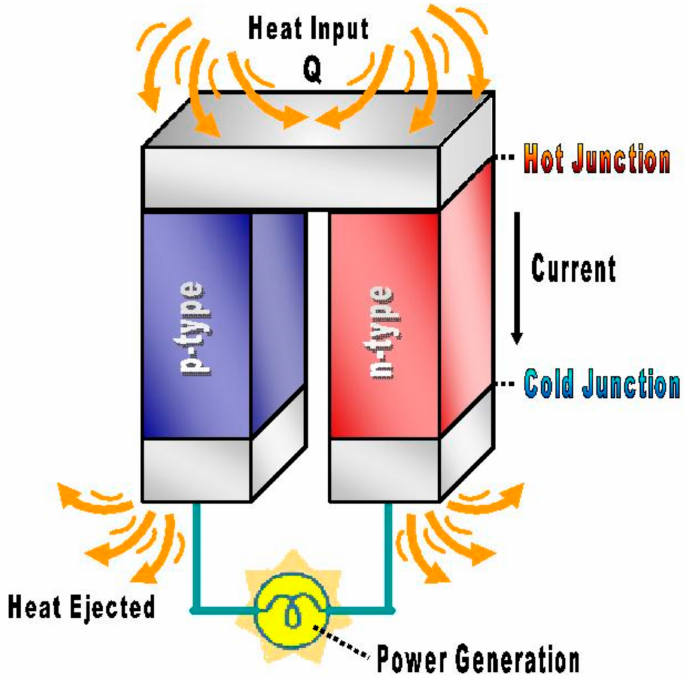
Figure 10. The Seebeck Effect